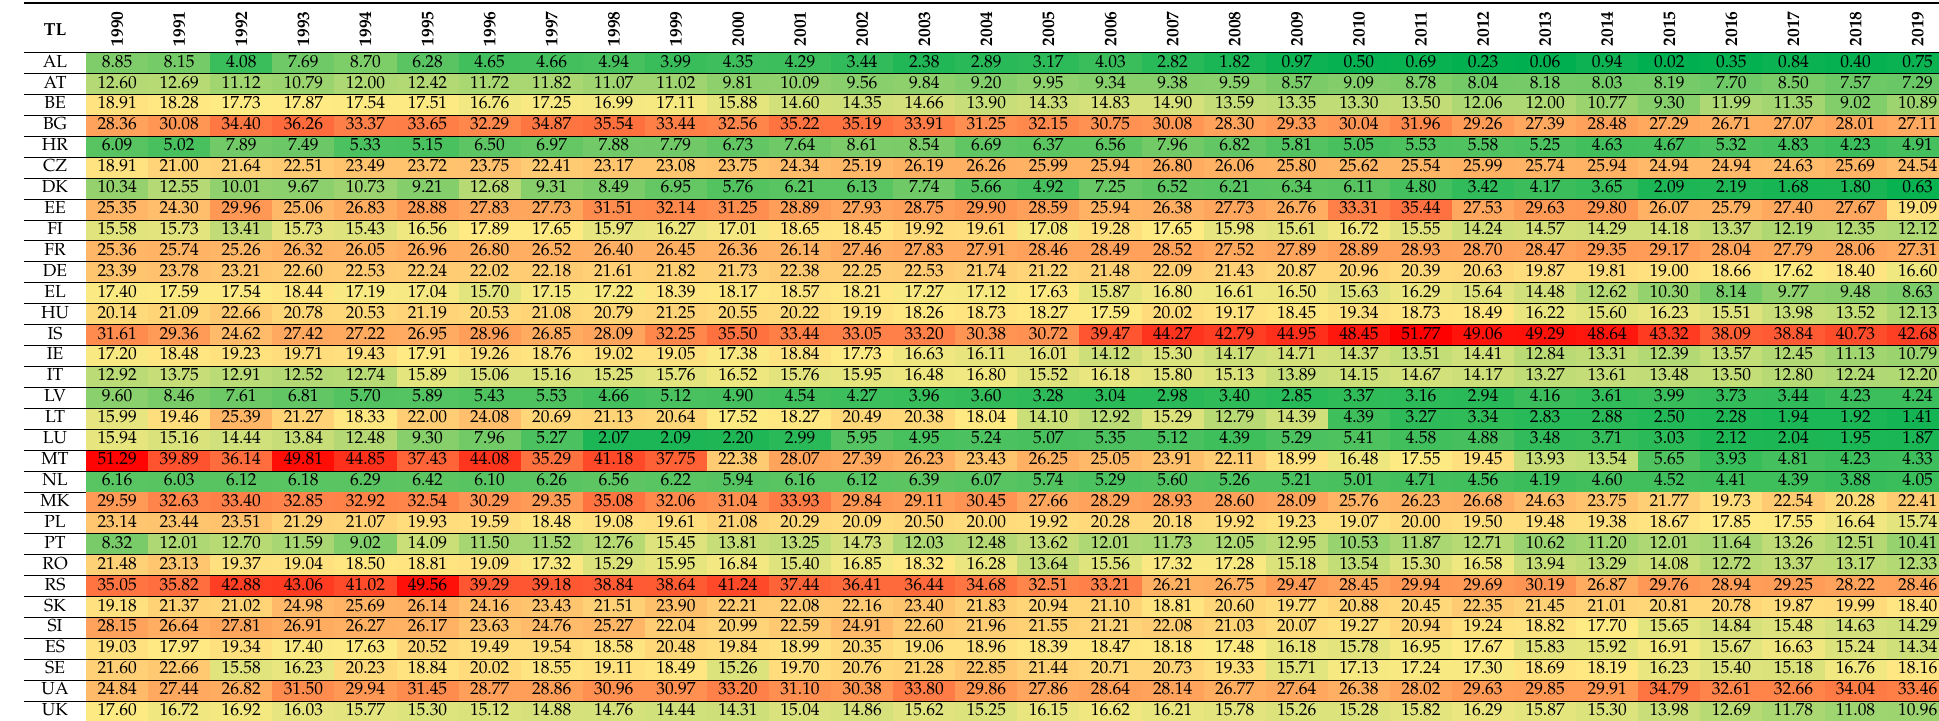
Table A1. Transformation losses (% of available energy from all sources), 1990–2019 (based on the Eurostat’s data (ec.europa.eu/eurostat/, accessed on 17 August 2022); © European Union,